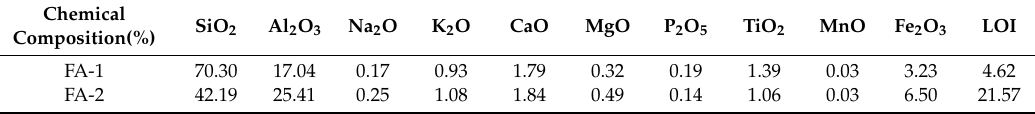
Table 3. Chemical composition of FA–1 and FA-2.